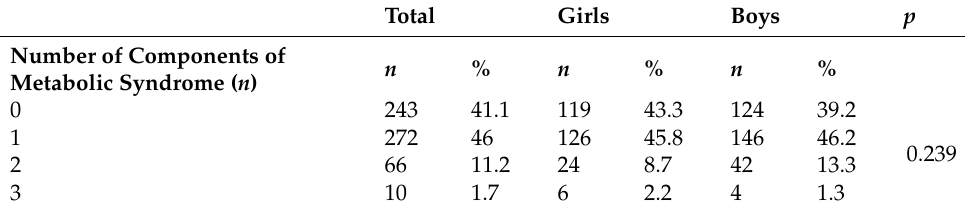
Table 2. Number of components of metabolic syndrome in girls and boys. Total Girls Boys p Number of Components of n % n % Metabolic Syndrome ( n )